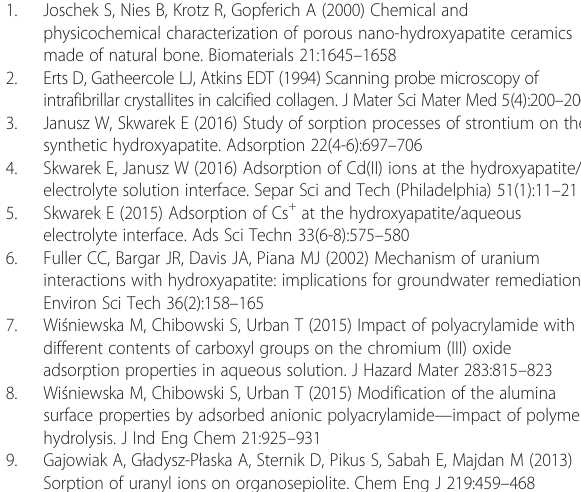
Table 6 Parameters of the isotherm models for the adsorption of U(VI) ions on the C-HAP